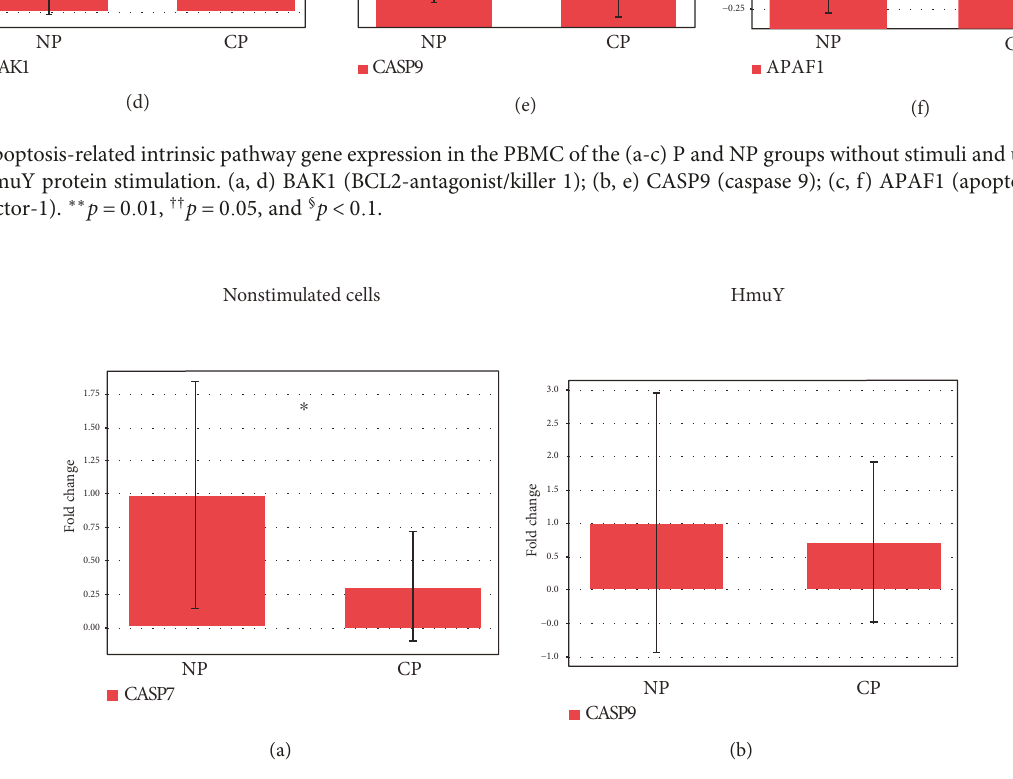
Figure 4: Caspase 7 expression in the PBMC of the (a) P and NP groups without stimulation (nonstimulated cells) and under (b) P. gingivalis HmuY protein stimulation. Caspase 7 (apoptosis-related cysteine peptidase). ∗ p = 0 05 .